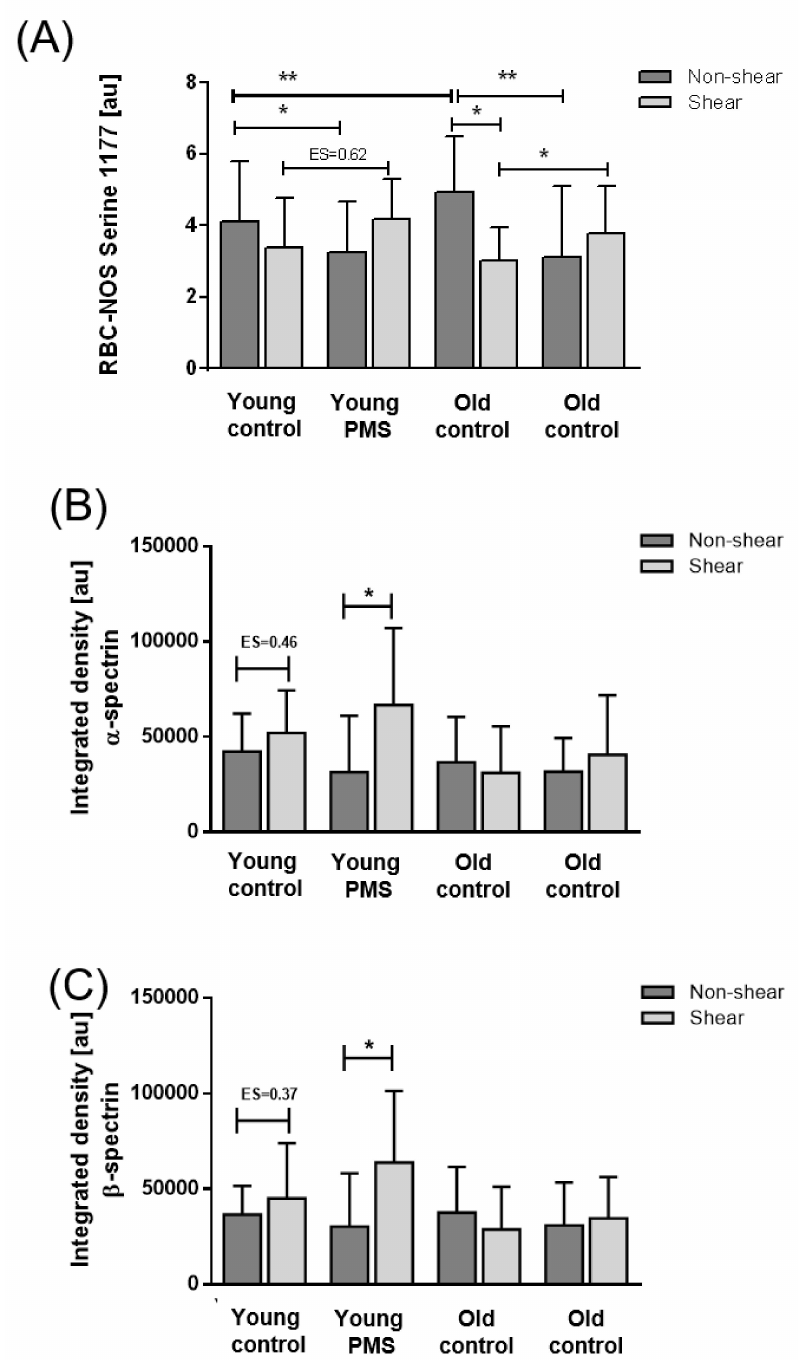
Figure 3. RBC nitric oxide synthase (RBC-NOS) activation and S-nitrosylation of the cytoskeletal spectrins in the RBC sub-fractions after exposure to PMS and prolonged shear stress. ( A ) RBC- NOS activation, reflected by serine 1177 phosphorylation, significantly decreased in young RBCs after PMS incubation ( p < 0.05). Shear stress application following PMS incubation increased RBC- NOS activation in young RBCs (ES = 0.62). In old RBCs, RBC-NOS activation decreased after PMS application but also after shear stress exposure. Shear stress following PMS application led to a significant increase in RBC-NOS activation when compared to shear stress condition solely. S-nitrosylation of ( B ) α -spectrin and ( C ) β -spectrin increased in young control and PMS-treated RBCs after shear stress exposure while no such an effect was observed in old